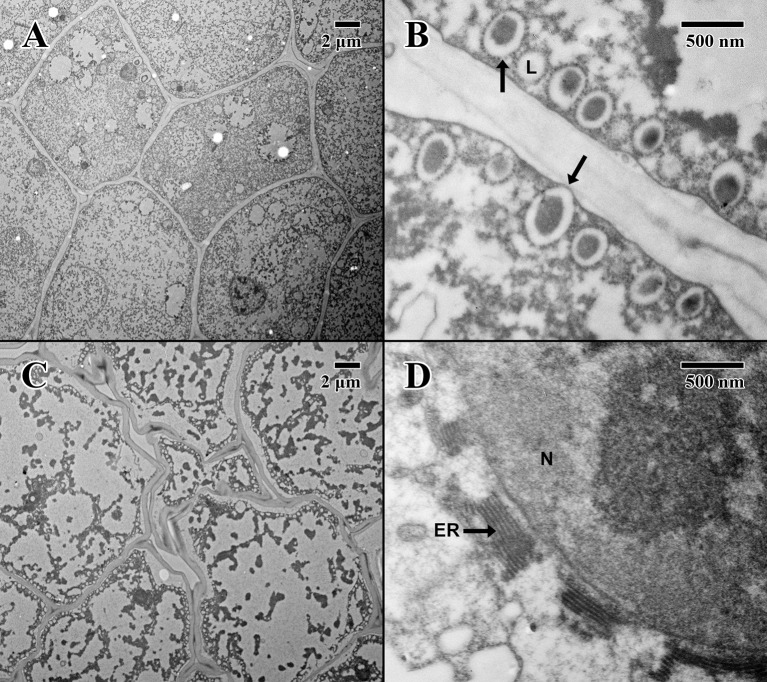
Transmission electron microscope micrographs of cotyledon parenchyma in date palm embryos in dry state. (A) ×1,000 2004 embryo (MSB accession no. 211945). Scale bar = 2 μm. (B) ×10,000 2004 embryo (MSB accession no. 211945). Scale bar = 500 nm. (C) ×1,000 1873 embryo (EBC accession no. 36007). Scale bar = 2 μm. (D) ×10,000 1873 embryo (EBC accession no. 36007). Scale bar = 500 nm. (N, nucleus; L, lipid body; ER, endoplasmic reticulum; arrows = explained in text).